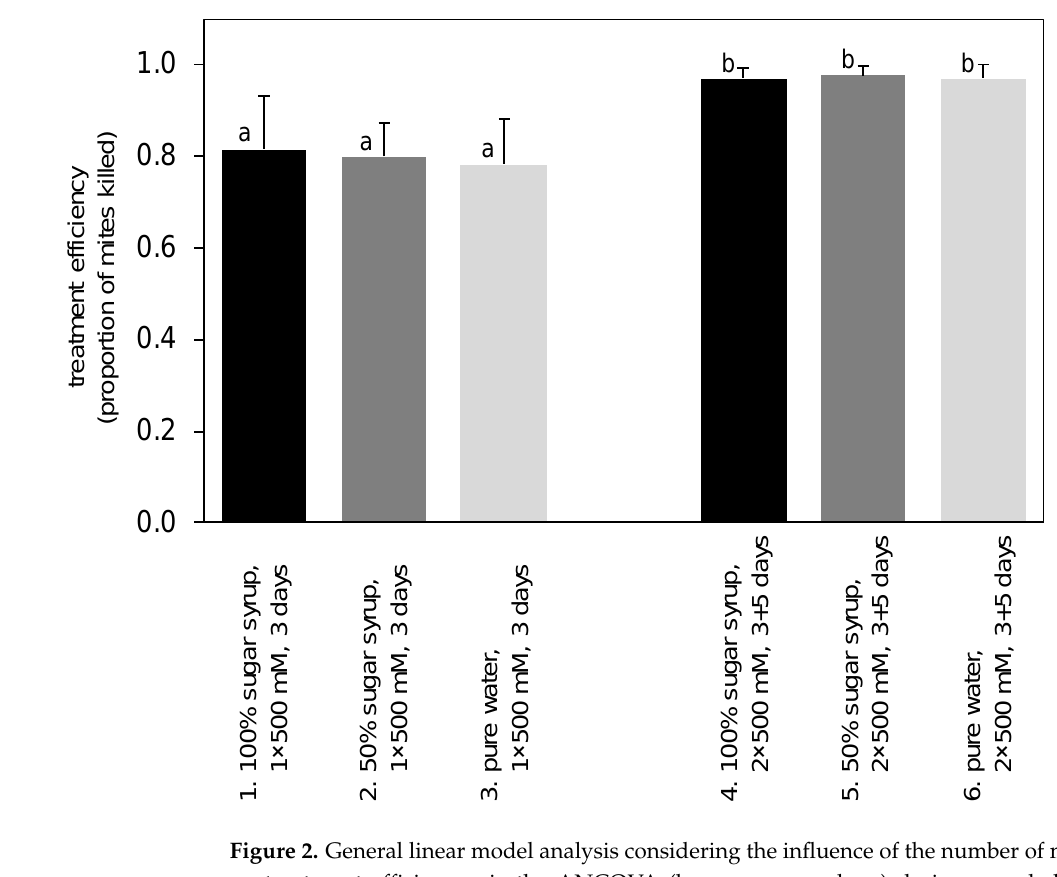
Table 4. General linear model analysis considering the influence of the number of mites (covariate) on treatment efficiency via the ANCOVA (homogeneous slope) design revealed that the efficiency of anti- Varroa LiCl treatments did not vary with the sugar concentration of the trickling solution, whereas it differed between single and repeated treatments. Results of Tukey HSD post hoc tests